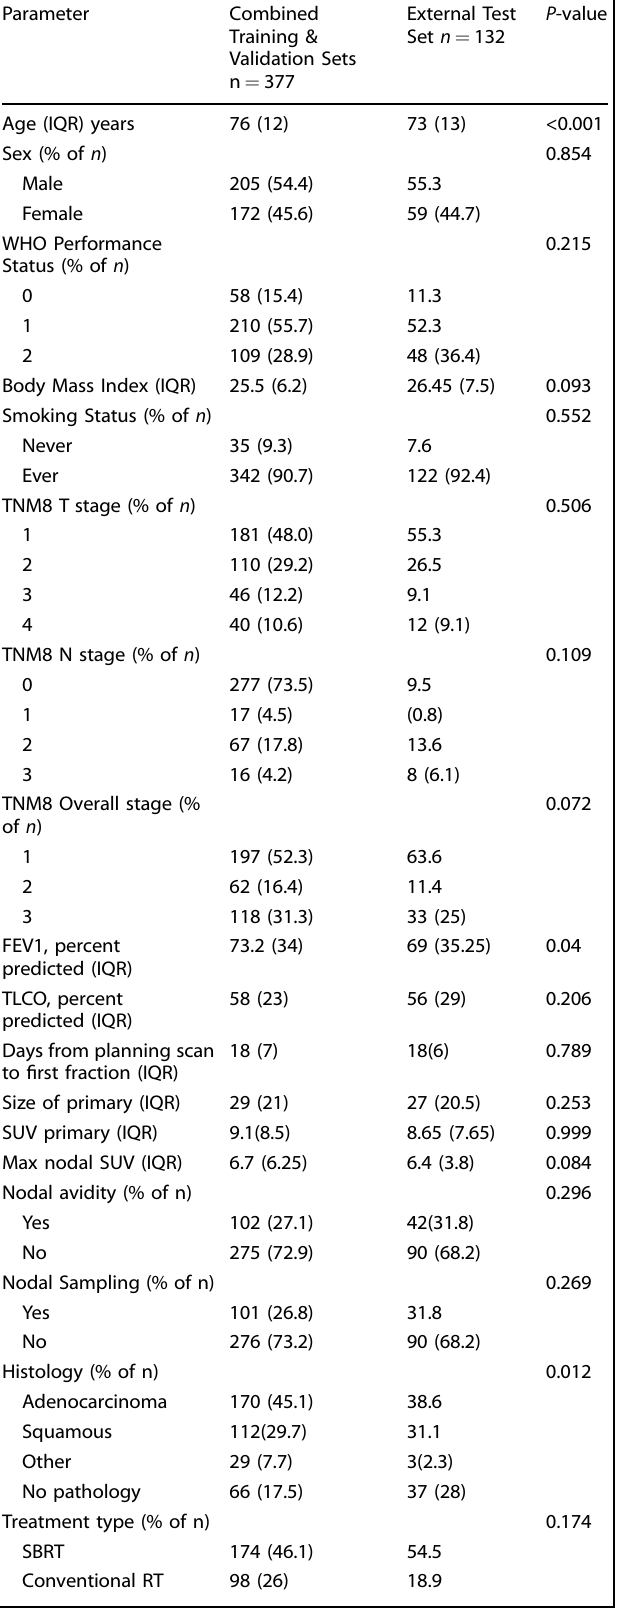
Table 1. Demographic and clinical parameters for combined training- validation and external test sets.